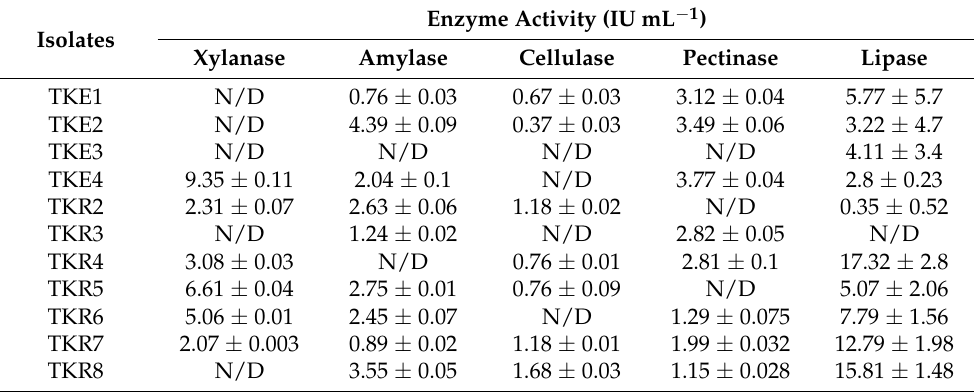
Table 4. Amounts of enzymes produced by each of the isolates using commercial substrates shown in international units of enzyme (IU mL − 1 ).